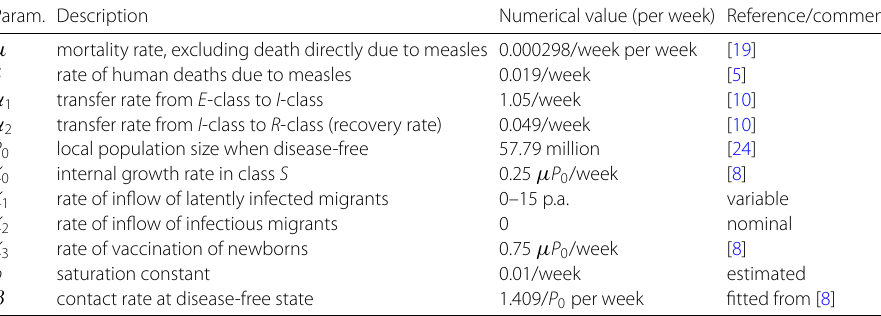
Table 1 Numerical values of parameters Param.